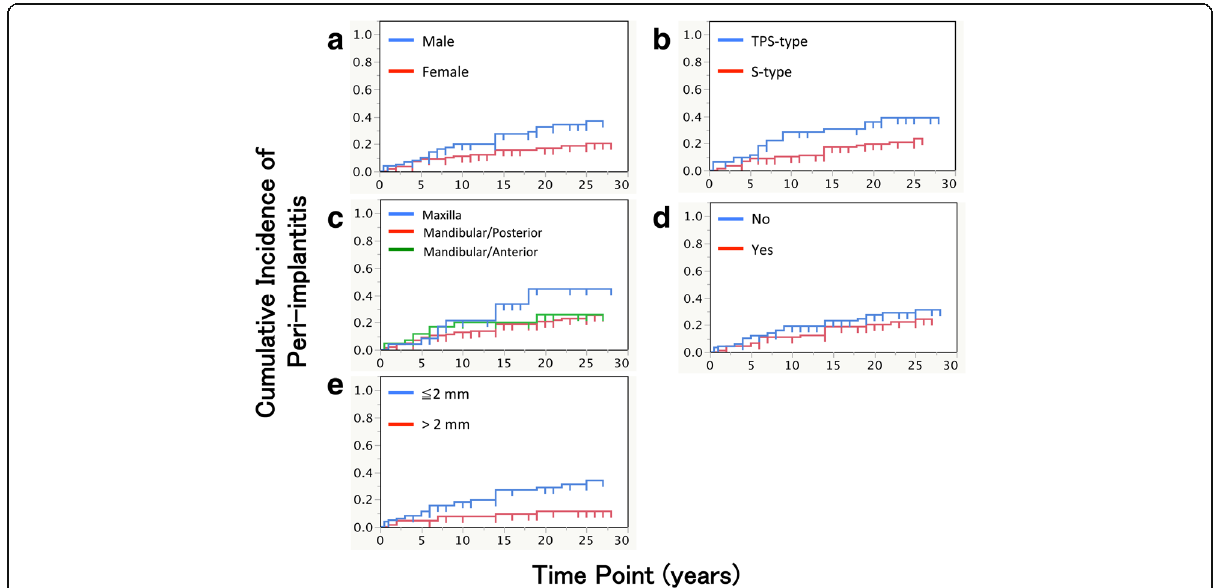
Fig. 4 Cumulative incidence of peri-implantitis by a gender ( p = 0.0221), b implant type ( p = 0.0128), c implant position ( p = 0.2470), d presence of additional soft tissue management ( p = 0.2488), and e width of keratinized mucosa around implant ( p = 0.0045). Log rank test was used for